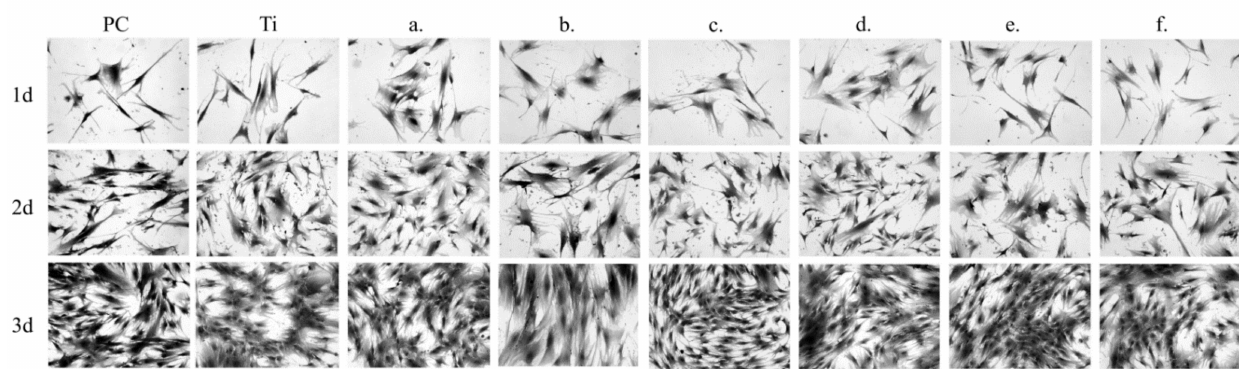
Figure 7. Morphology of the normal human osteoblast (NHost) cells cultured for a different time: 24 h, 3 days, and 5 days: Ti31Mo ( a ), Ti31Mo after hydrothermal treatment (HT) ( b ), Ti31Mo5HA ( c ), Ti31Mo5HA1Ag ( d ), Ti31Mo5HA2CeO 2 ( e ), Ti31Mo5HA2Ta 2 O 5 ( f ).